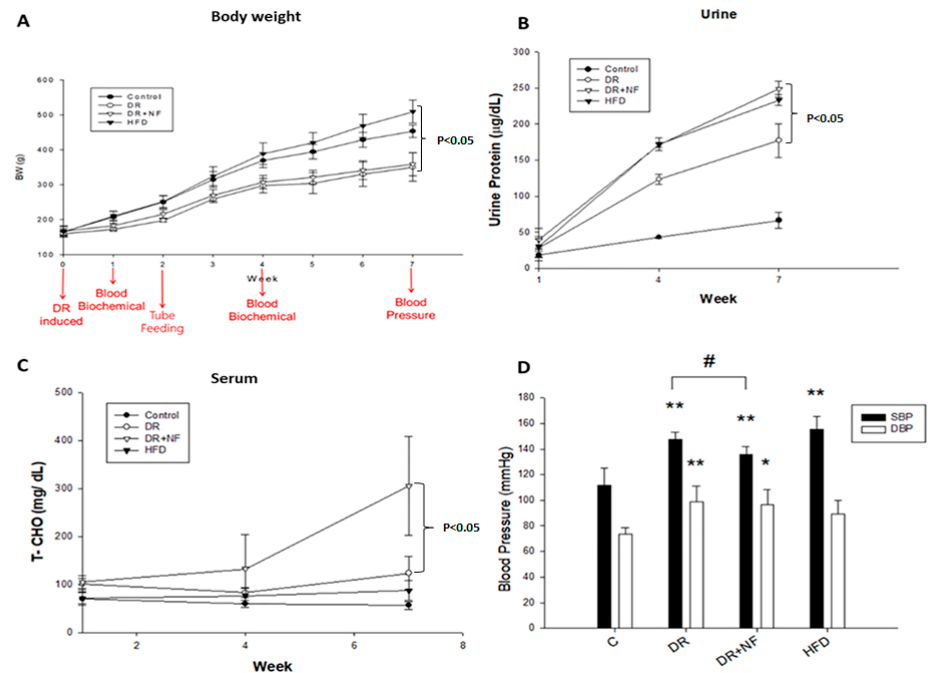
Figure 1. Changes in body weight (BW), urine protein and serum cholesterol levels, and blood pressure (BP) in rats. ( n = 3 for each group) ( A ) At week 7, the bodyweight of the high-fat diet (HFD) group was higher than that of the DR + NF group (500 vs. 320 g; p < 0.05). ( B ) The DR + NF group had a higher urine protein level than the DR group ( p < 0.05) at week 7. ( C ) The DR + NF group had higher serum total cholesterol than the DR group ( p < 0.05) at week 7. ( D ) DR + NF, DR, and HFD groups had higher systolic pressure (** p < 0.05) compared to the control group. DR + NF and DR groups showed higher diastolic pressure than the control (** p < 0.05 and * p < 0.1, respectively). The DR + NF group had lower BP compared to the DR group. ( # p < 0.05).